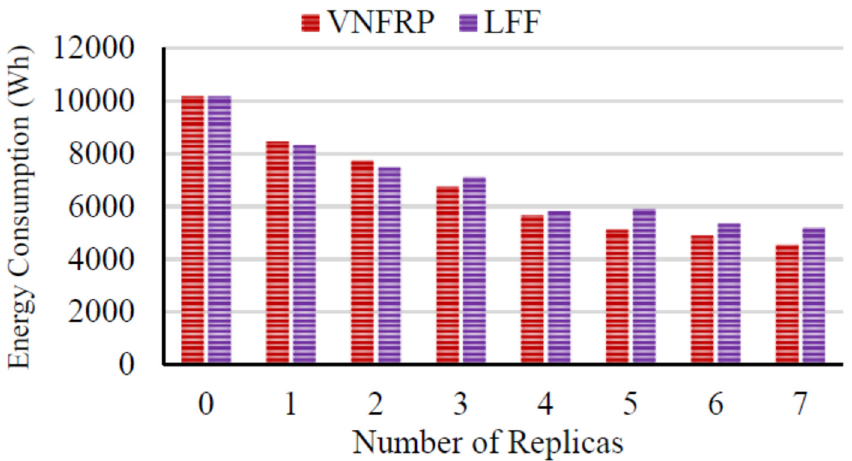
Figure 6. Network energy consumption in the cloud network when adopting the VNFRP algorithm and the corresponding values when adopting the LFF strategy.